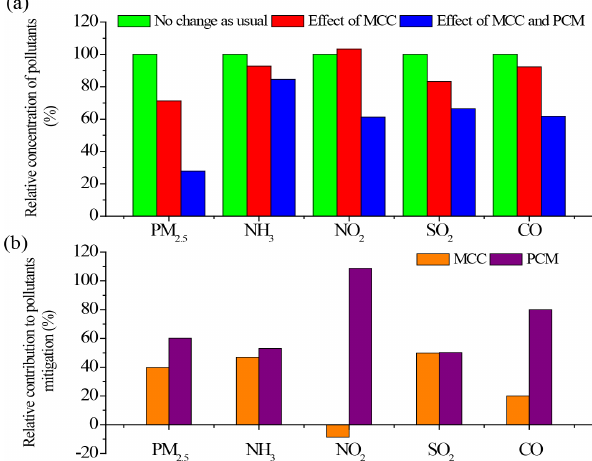
Figure 11. Effect of meteorological condition change (MCC, sim- ulated by a GEOS-Chem chemical transport model) and pollution control measures (PEM, measured by monitoring stations) to rela- tive concentrations of CO, NO 2 , SO 2 , NH 3 and PM 2 . 5 (a) and rela- tive contribution of MCC and PEM to major pollutant mitigation (b) in Beijing during the Parade Blue